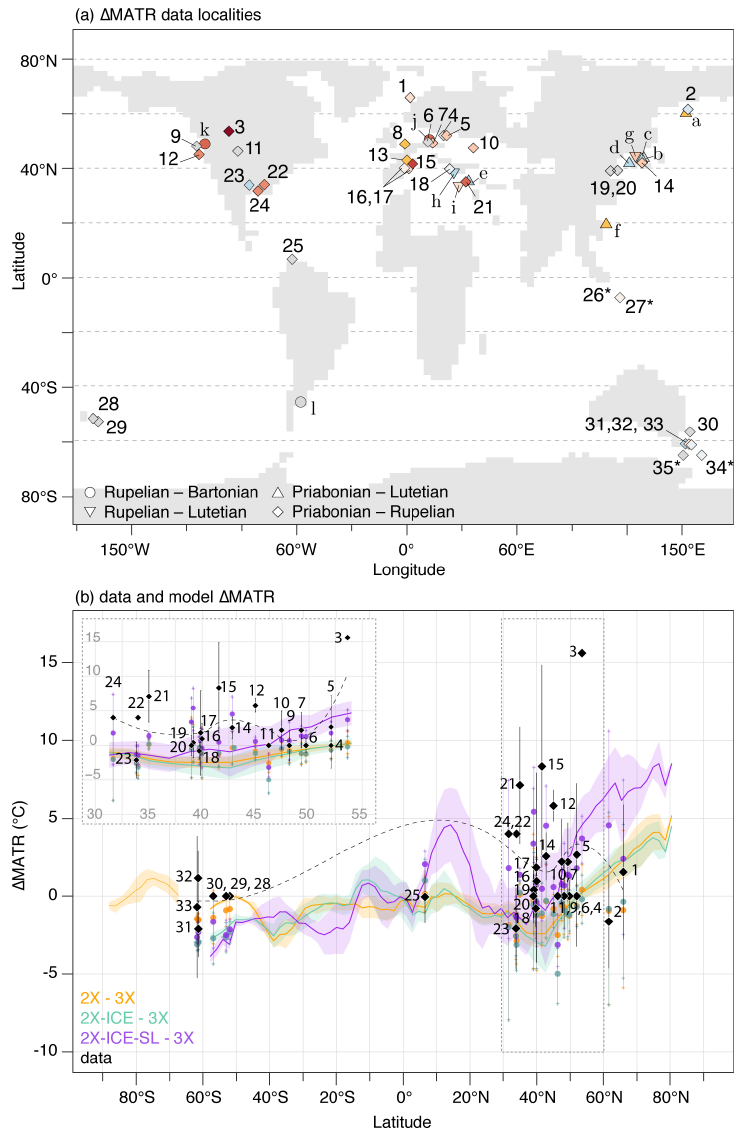
Figure 8. Data–model comparison of (cid:49) MATR from the Priabonian to the Rupelian. (a) Map of all data (cid:49) MATR estimates compiled in this study (symbols refer to the time period compared for the calculation of the MATR shift; see Table S1 in the Supplement for associated references). The points marked with an asterisk have an uncertain origin (marine sediments) and have not been taken into account in the statistical analyses although they are shown here. (b) Comparison of data estimates of Priabonian–Rupelian (cid:49) MATR (black diamonds) to modeled (cid:49) MATR at the same localities (colored circles, calculated over a 3 × 3 ◦ area) from different pairs of simulations with 3 X . Error bars are minimum and maximum data estimates of (cid:49) MATR. The dashed black line is the LOESS curve associated with data (cid:49) MATR estimates. Bold colored lines indicate the continental latitudinal gradient of (cid:49) MATR on land (i.e., all longitudes averaged per degree of latitude); color-shaded intervals are the standard deviation around the average. A subfigure similar to (b) but using the simulation 4 X as a Priabonian stage is available in the Supplement, Fig.